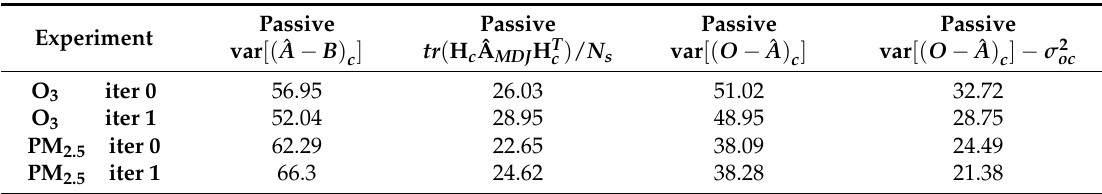
Table 3. Analysis statistics against passive observations.